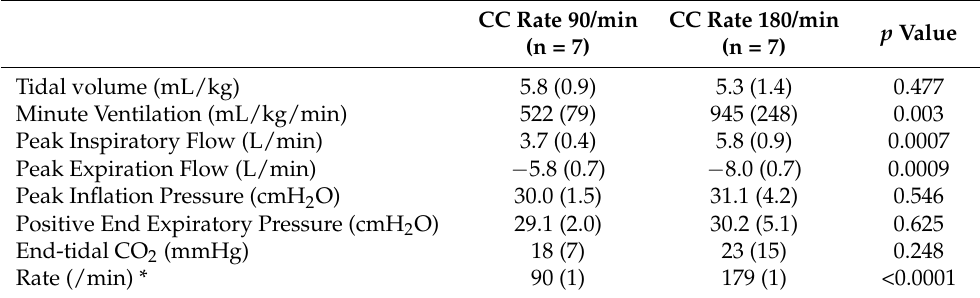
Table 2. Respiratory parameters during CPR.